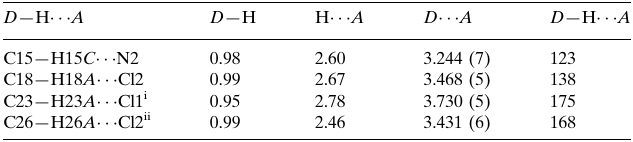
Hydrogen-bond geometry (A˚ , (cid:2)